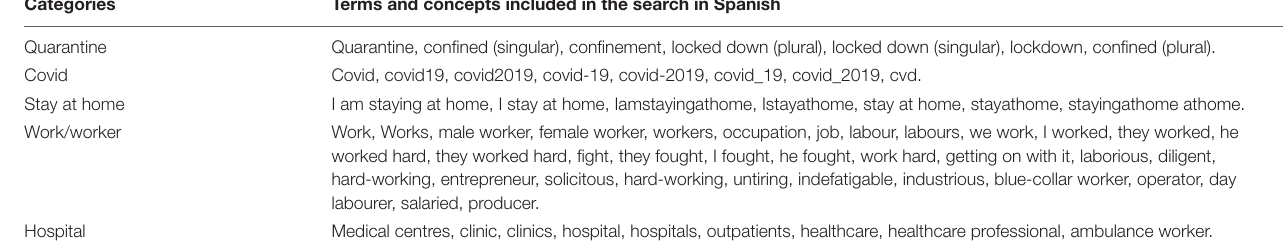
TABLE 4 | Analysis categories related to the coronavirus setting.